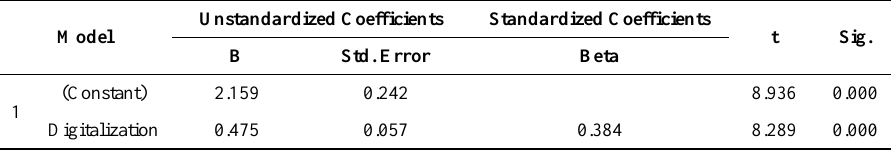
Table 8. OLS model for digitalization and customer loyalty